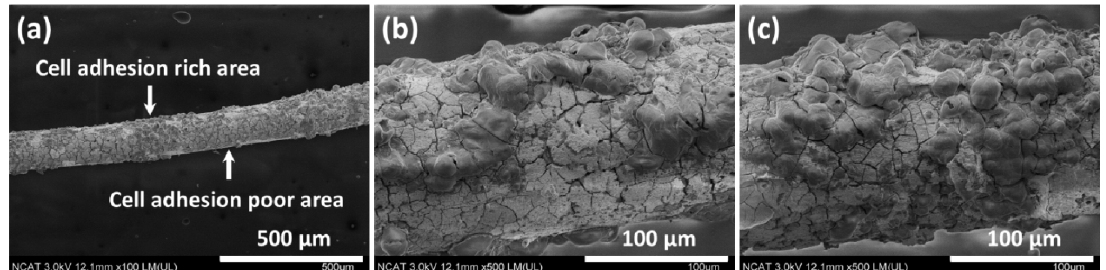
Figure 12. SEM images of Porcine Tracheal Epithelial (PTE) cells adhered on the surfaces of pure magnesium wire after the cell adhesion test for 12 h: ( a ) Low magnification image of pure magnesium wire after cell adhesion test; ( b ) High magnification image of cell adhesion poor area; ( c ) High magnification image of cell adhesion rich